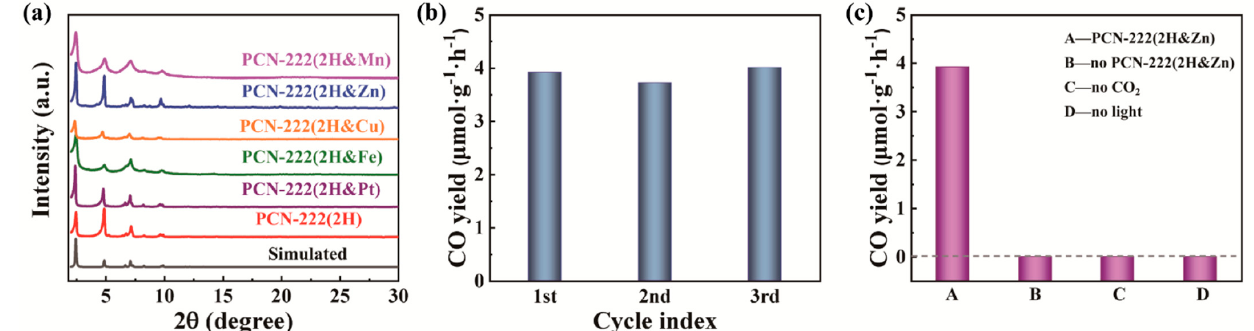
Figure 6. ( a ) PXRD patterns for PCN-222 materials after photocatalytic reactions, ( b ) the average CO yield of PCN-222(2H&Zn) during the 1st, 2nd, and 3rd photocatalytic CO 2 RR process, respectively; ( c ) blank tests of CO 2 RR under different conditions (A: normal conditions, B: without PCN- 222(2H&Zn), C: without CO 2 in N 2 atmosphere, and D: without light).